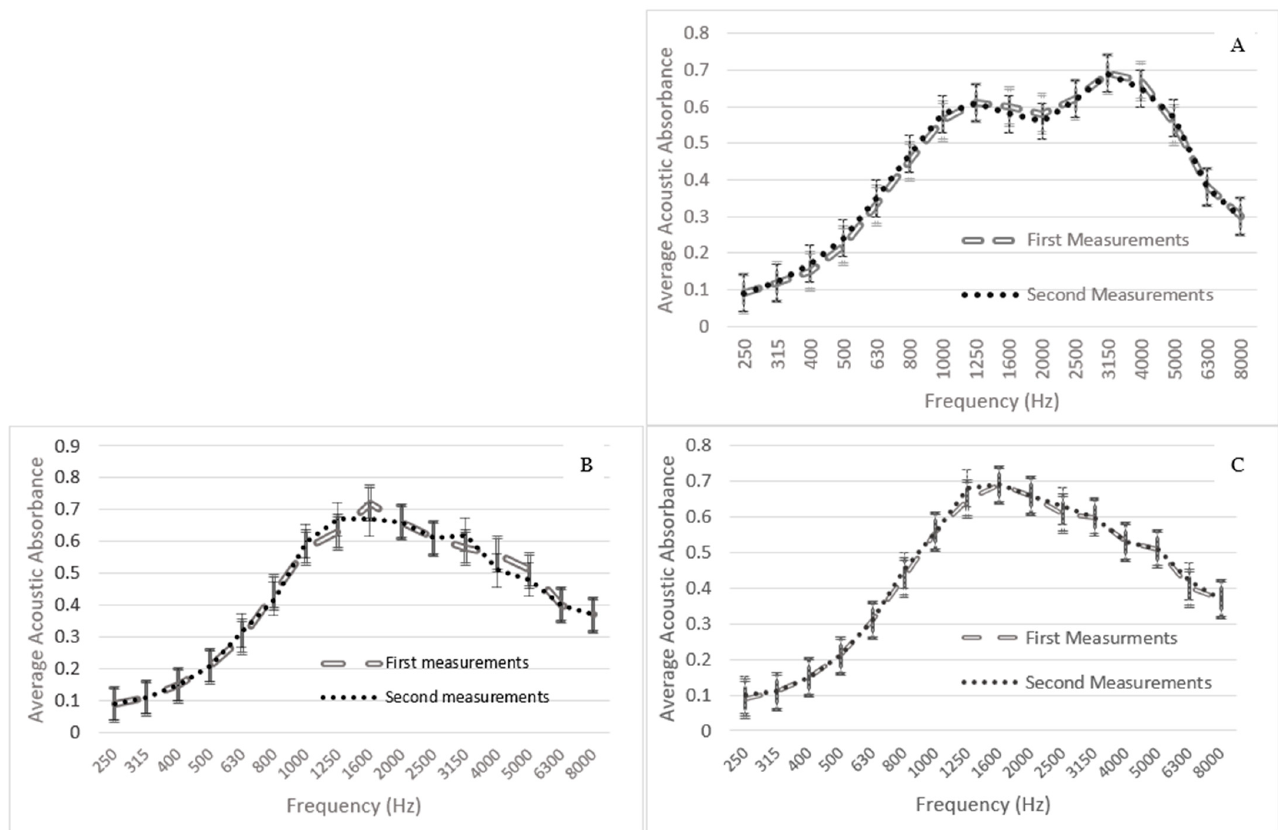
Figure 2. Comparison between first and second wideband tympanometry measurements for: ( A ) normal-hearing ears (n = 35); ( B ) implanted ears (n = 19); ( C ) impaired-hearing non-implanted ears (n = 15). The bars reflect the 95% confidence intervals.